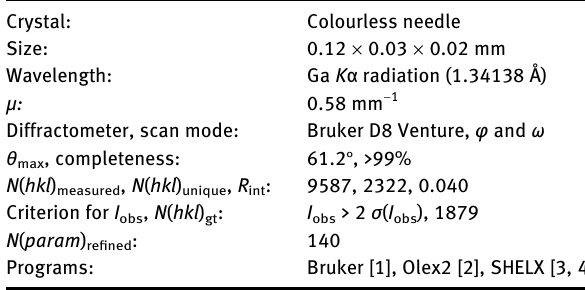
Table 1 contains crystallographic data and Table 2 contains the list of the atoms including atomic coordinates and displacement parameters.